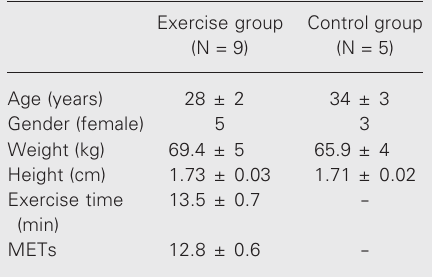
Table 1. Demographic and exercise-related re- sults.